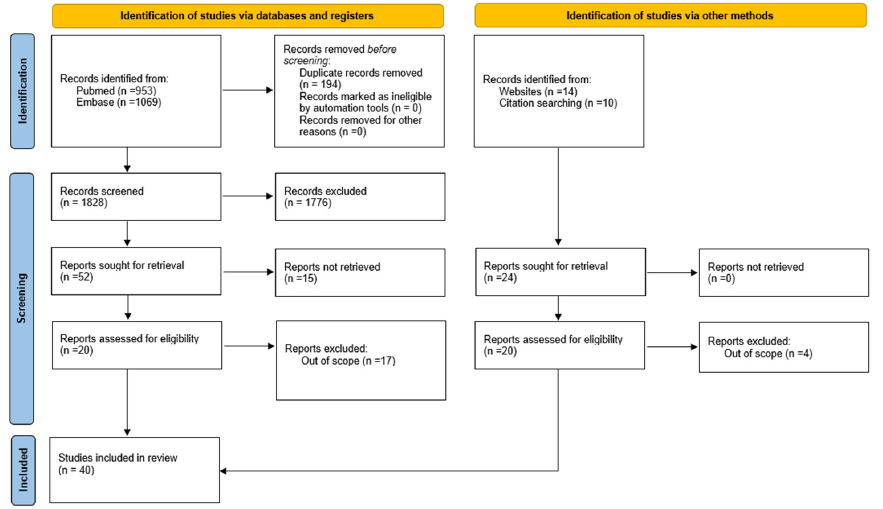
Figure 1. PRISMA flow diagram that included searches of databases, registers and other sources [12].